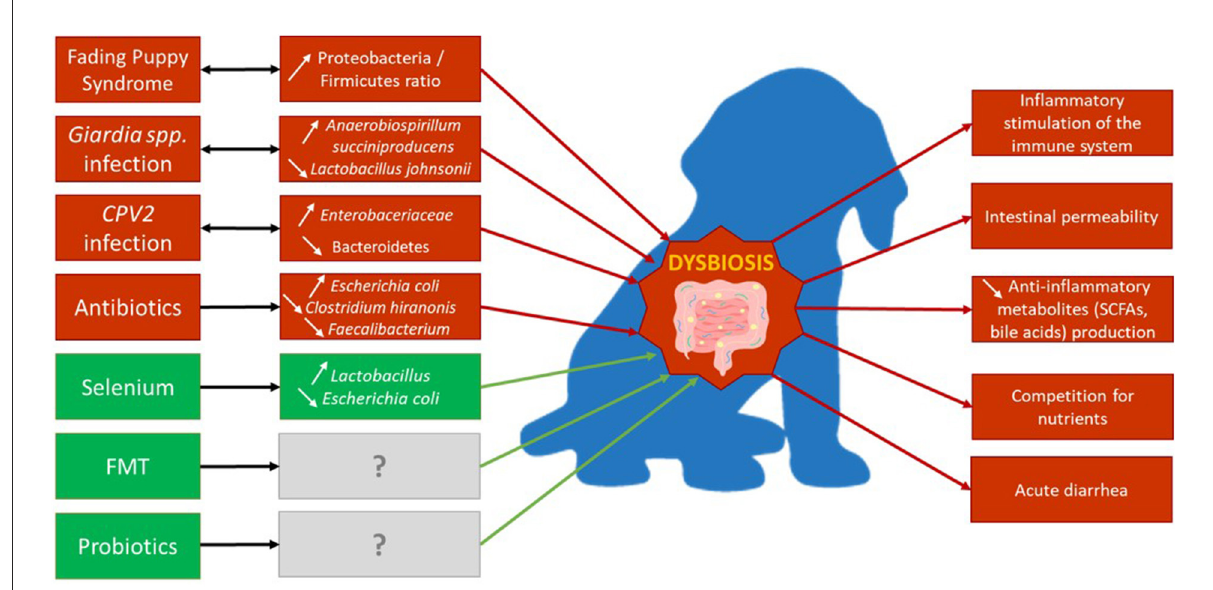
FIGURE4 Major factors of dysbiosis in growing dogs’ gut and their effects on microbial composition. Red boxes and arrows indicate factors inducing dysbiosis and its consequences, while green ones may participate in decreasing dysbiosis. Gray boxes indicate an unknown effect on microbiota